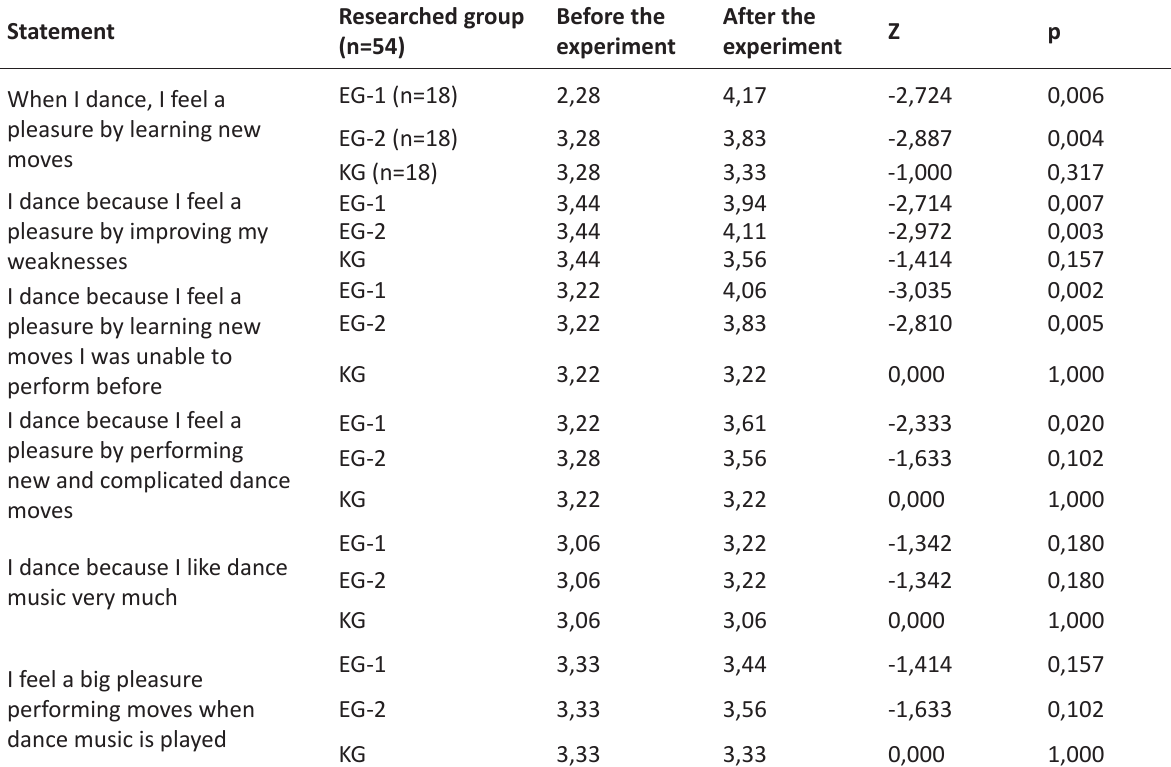
Table 2. Mean evaluation of alternation of acceptance of the statements of the subscale of the internal motivation “to strive for perfection” in juvenile (9–11 years old) sports dancers during the 12-week period of the experiment in points